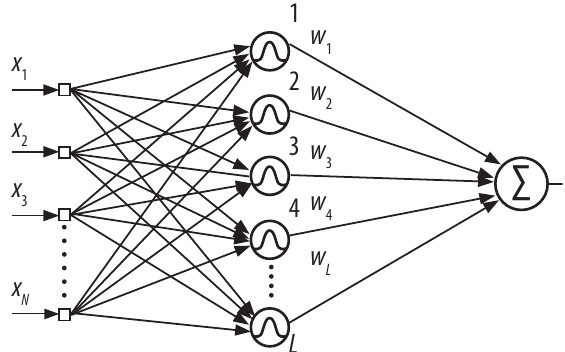
Fig. 2. Structure of a typical RBNN